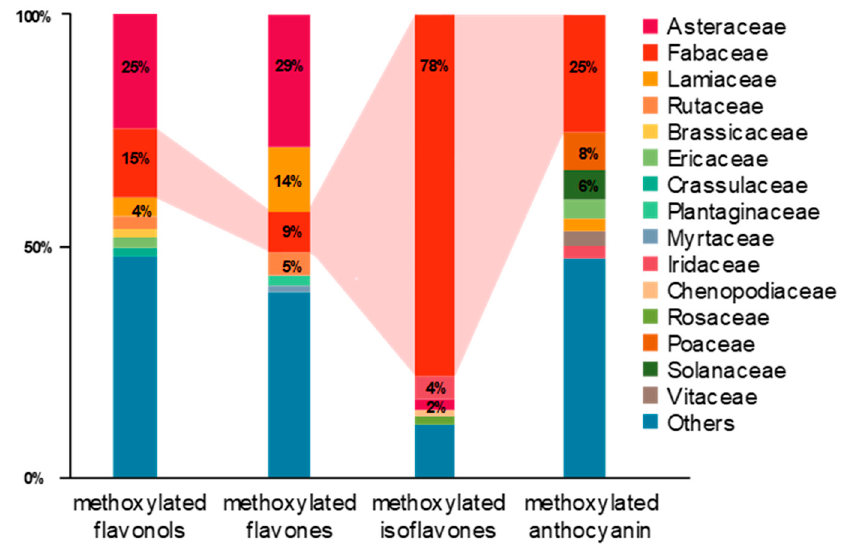
Figure 3. Methoxylated flavonoids reported in plant species. By searching the keywords “quercetin”, ”kaempferol”, “isorhamnetin”, “myricetin”, “flavonol”, “luteolin”, “tricetin”, “apigenin”, “flavone”, “daidzein”, “glycitein”, “genistein”, “isoflavone”, “petunidin”, “malvidin”, “peonidin” and “anthocyanidin” in the KNApSAcK database (http://www.knapsackfamily.com/knapsack_core/top.php, accessed date: 14 May 2021), 322 out of 1046 flavonols, 788 out of 1298 flavones, 349 out of 573 isoflavones and 120 out of 506 anthocyanidins were found to be methoxylated flavonoids.